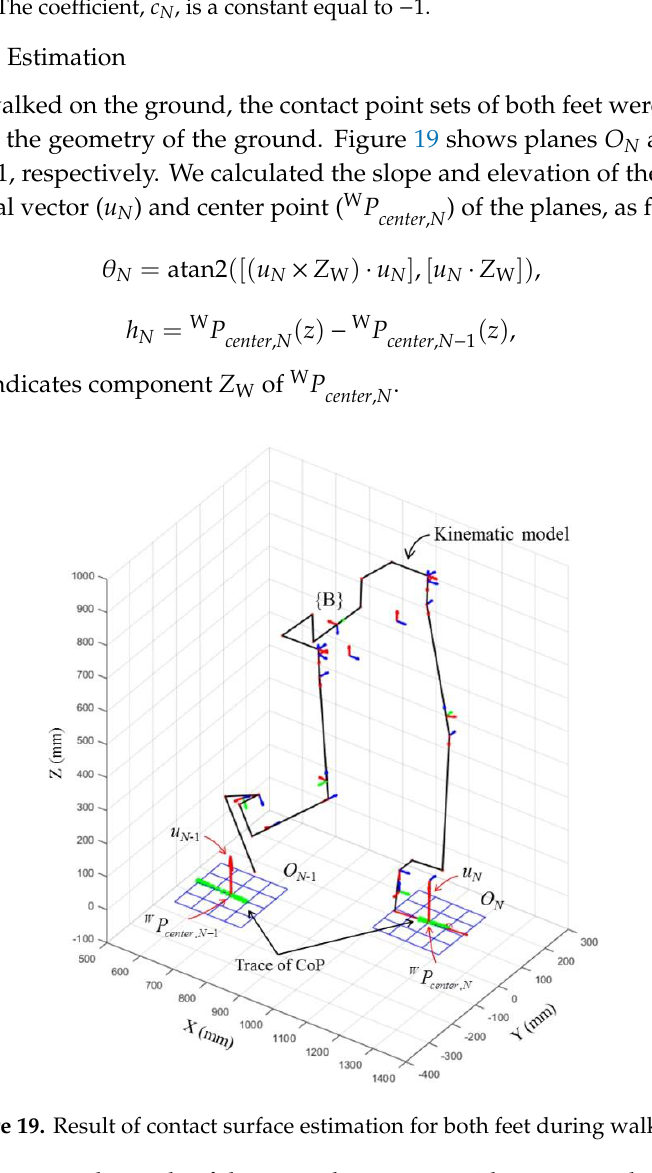
Figure 18. Updating process of the calculated plane coefficients while the exoskeleton is in contact with the ground. The coefficient, c N , is a constant equal to −1.